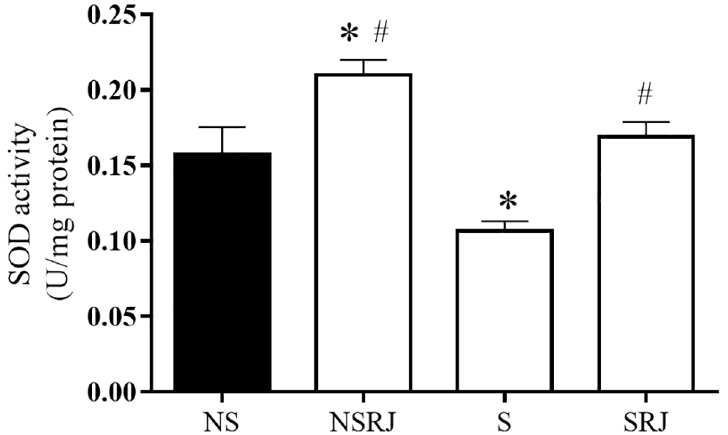
Fig 3. Superoxide dismutase activity in liver tissue of rats stressed by immobilization and cold. No stress (NS), No Stress supplemented with Royal Jelly (NSRJ), Stress (S) and Stress supplemented with Royal Jelly (SRJ). Values are expressed as mean±SEM, (cid:3) p < 0.05 vs. NS, # p < 0.05 vs. S (One-way ANOVA followed by Tukey test). Outliers were detected by performing Grubb’s test using an online GraphPad outlier calculator (http://graphpad.com/quickcalcs/